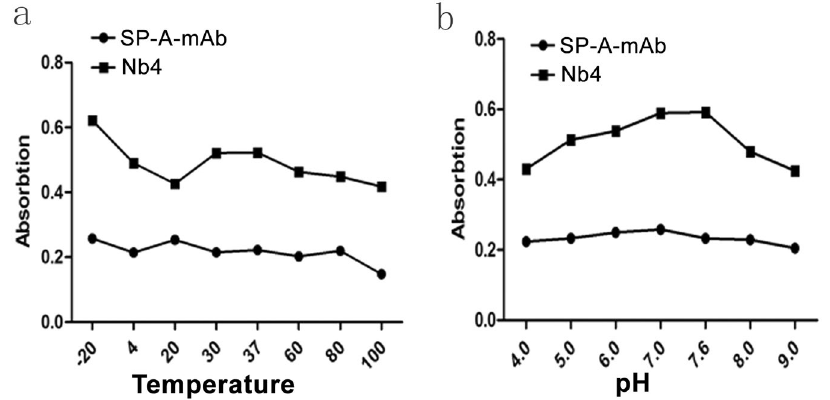
Figure 8. Physical properties of Nb4. ( a ) The effects of temperature on Nb4 stability. ( b ) The effects of pH on Nb4 stability. Nb4 was treated at different pH and temperature, and then was used for ELISA assay with human lung tissue total protein extracts as the antigen